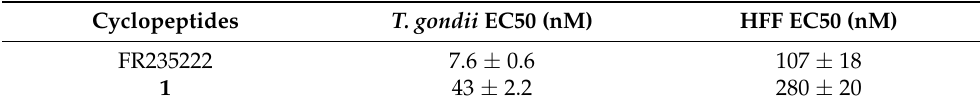
Table 1. Inhibition of T. gondii intracellular growth of RH strain tachyzoite and human cells HFF with compound 1 compared to the natural product